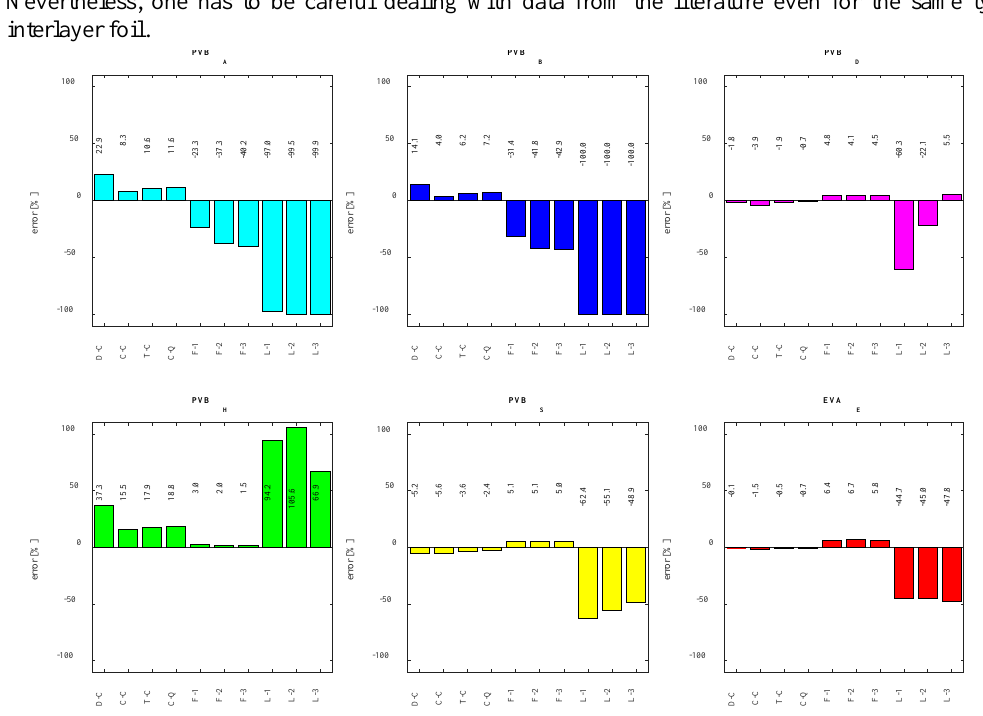
Fig. 6 Summary of errors for all tested quantities and all interlayers. (D-C deflection at the center, C-C compressive strain at the center, T-C tensile strain at the center, C-Q compressive strain at the quarter, F-1,2,3 natural frequency for the first, second, or third mode shape, L-1,2,3 loss factor for the first, second, or third mode